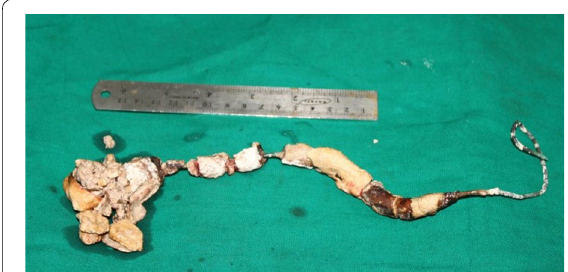
Fig. 2 The removed stent from the patient